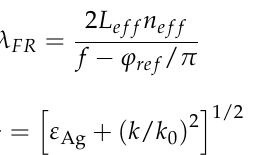
Figure 2. ( a ) Transmission spectra of the whole system, single stub and single racetrack ring resonator; ( b , c ) the magnetic field distribution H Z at λ = 1729 and 2000 nm, respectively.